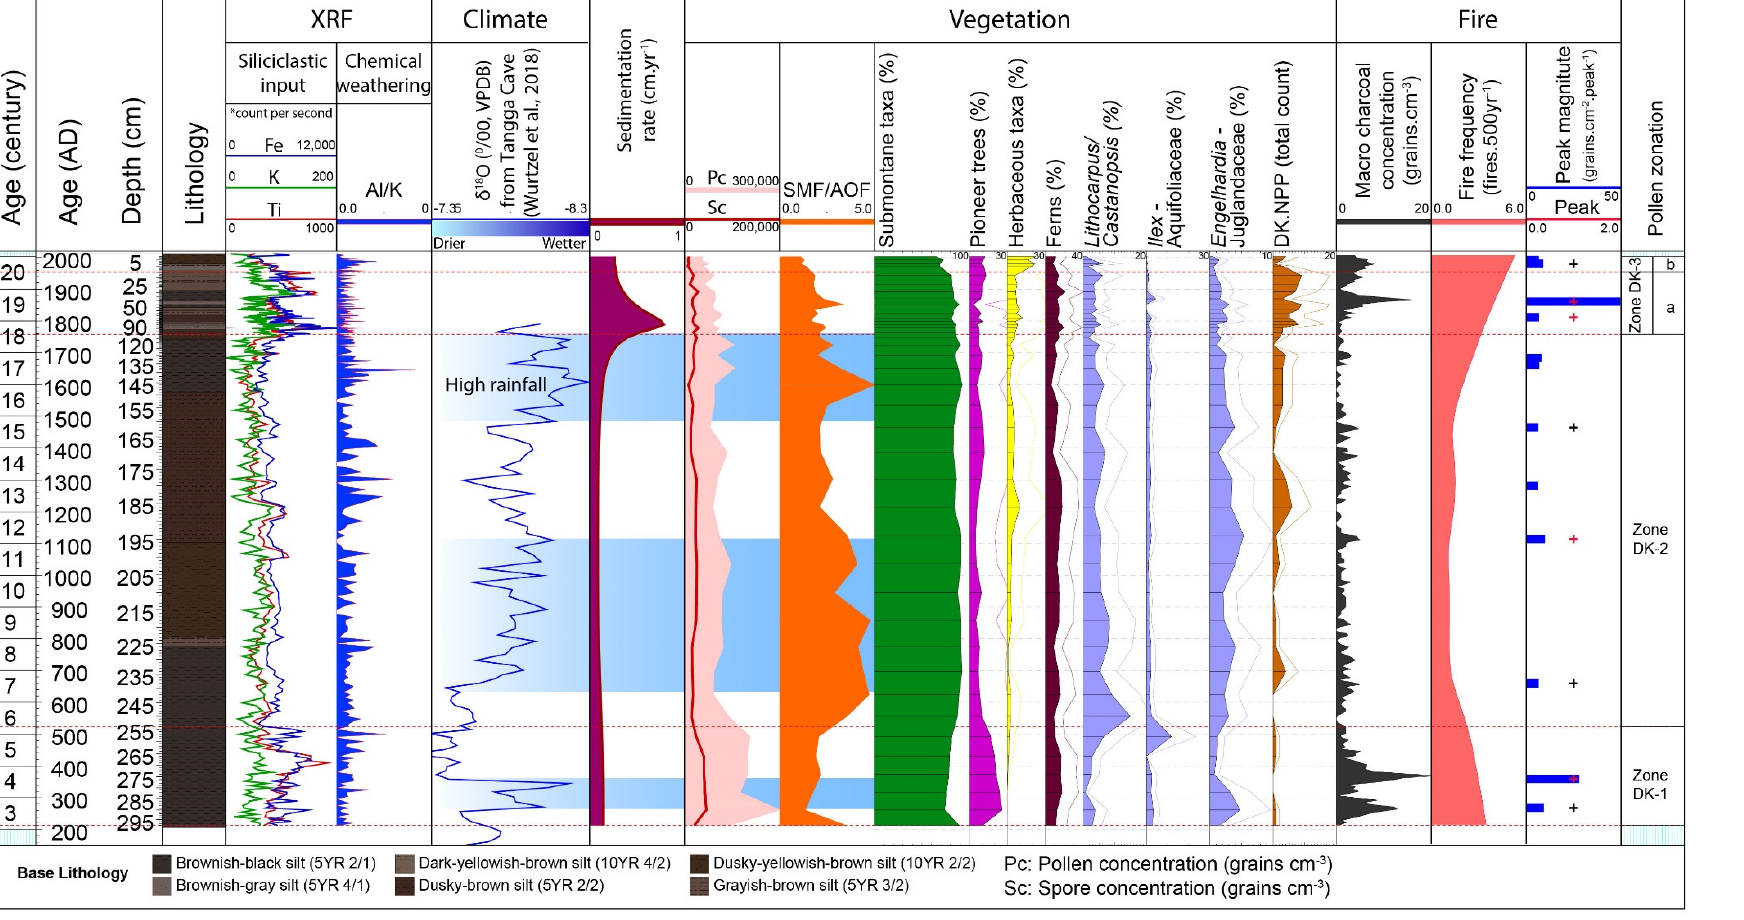
Figure 8. A palynological diagram of the DK core represents the total sum pollen and spore taxa for each ecological group, non-pollen palynomorph concentrations ( Glomus ), CharAnalysis results (macro charcoal concentration, fire peaks (red cross: fire peaks with a high SNI >3), peak magnitude, and fire frequency), XRF data (Ti, K, Fe, AI/K) and the climate data (paleo-precipitation record from Tangga Cave [19] ).